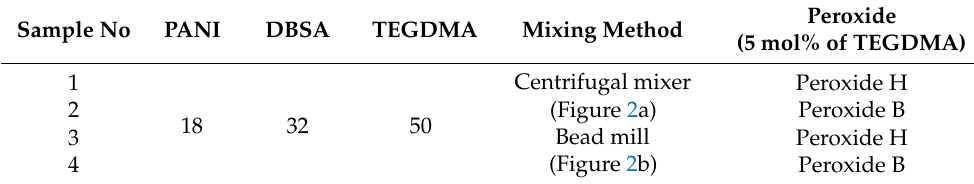
Table 1. Compositions of test specimens